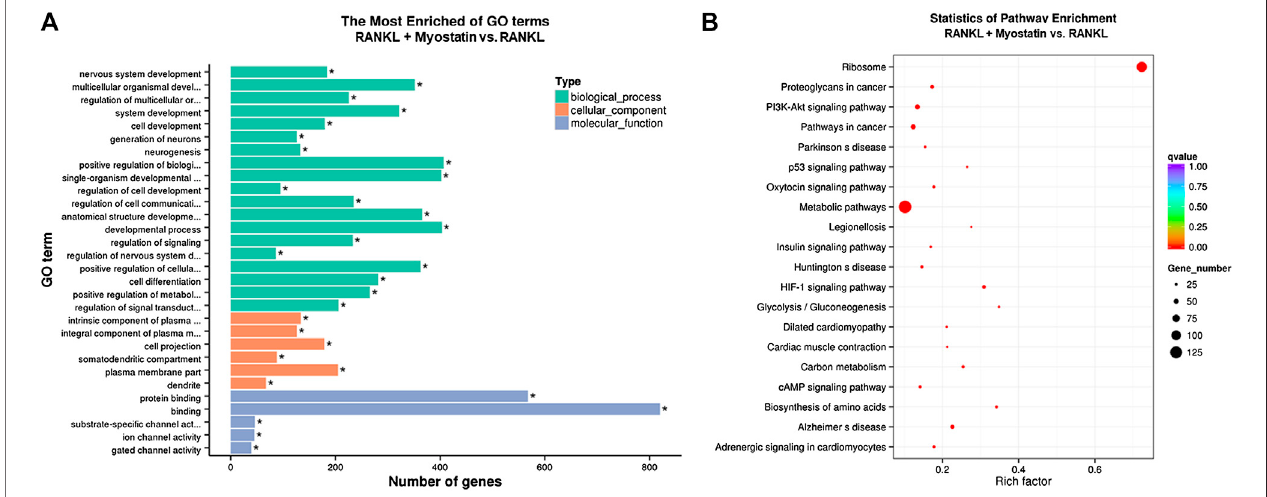
FIGURE 4 | Functional enrichment analysis of differentially expressed genes. (A) Differentially expressed genes in osteoclastogenesis were researched by GO analysis. (B) Differentially expressed genes in osteoclastogenesis were researched by KEGG analysis.